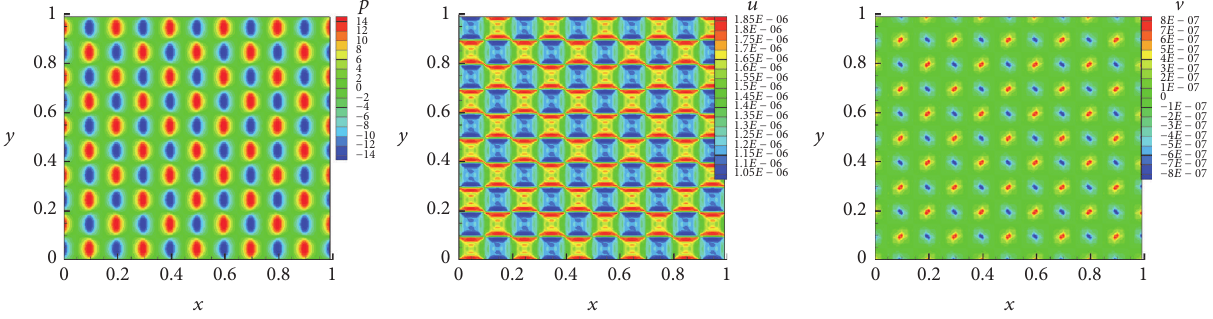
⃗𝐺 = (2,0) m s −2 , 𝜅 = 10 −12 m 2 , and 𝜅 const 1